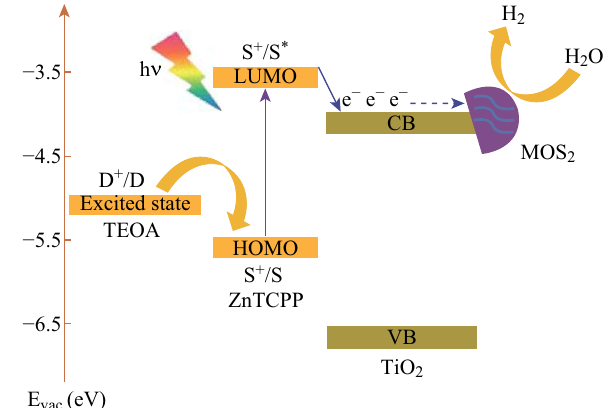
Fig. 7 Influence of zinc porphyrin functionalization on the surface of TiO 2 /MoS 2 in terms of electronic band structure. Reproduced with permission from Ref. [131]